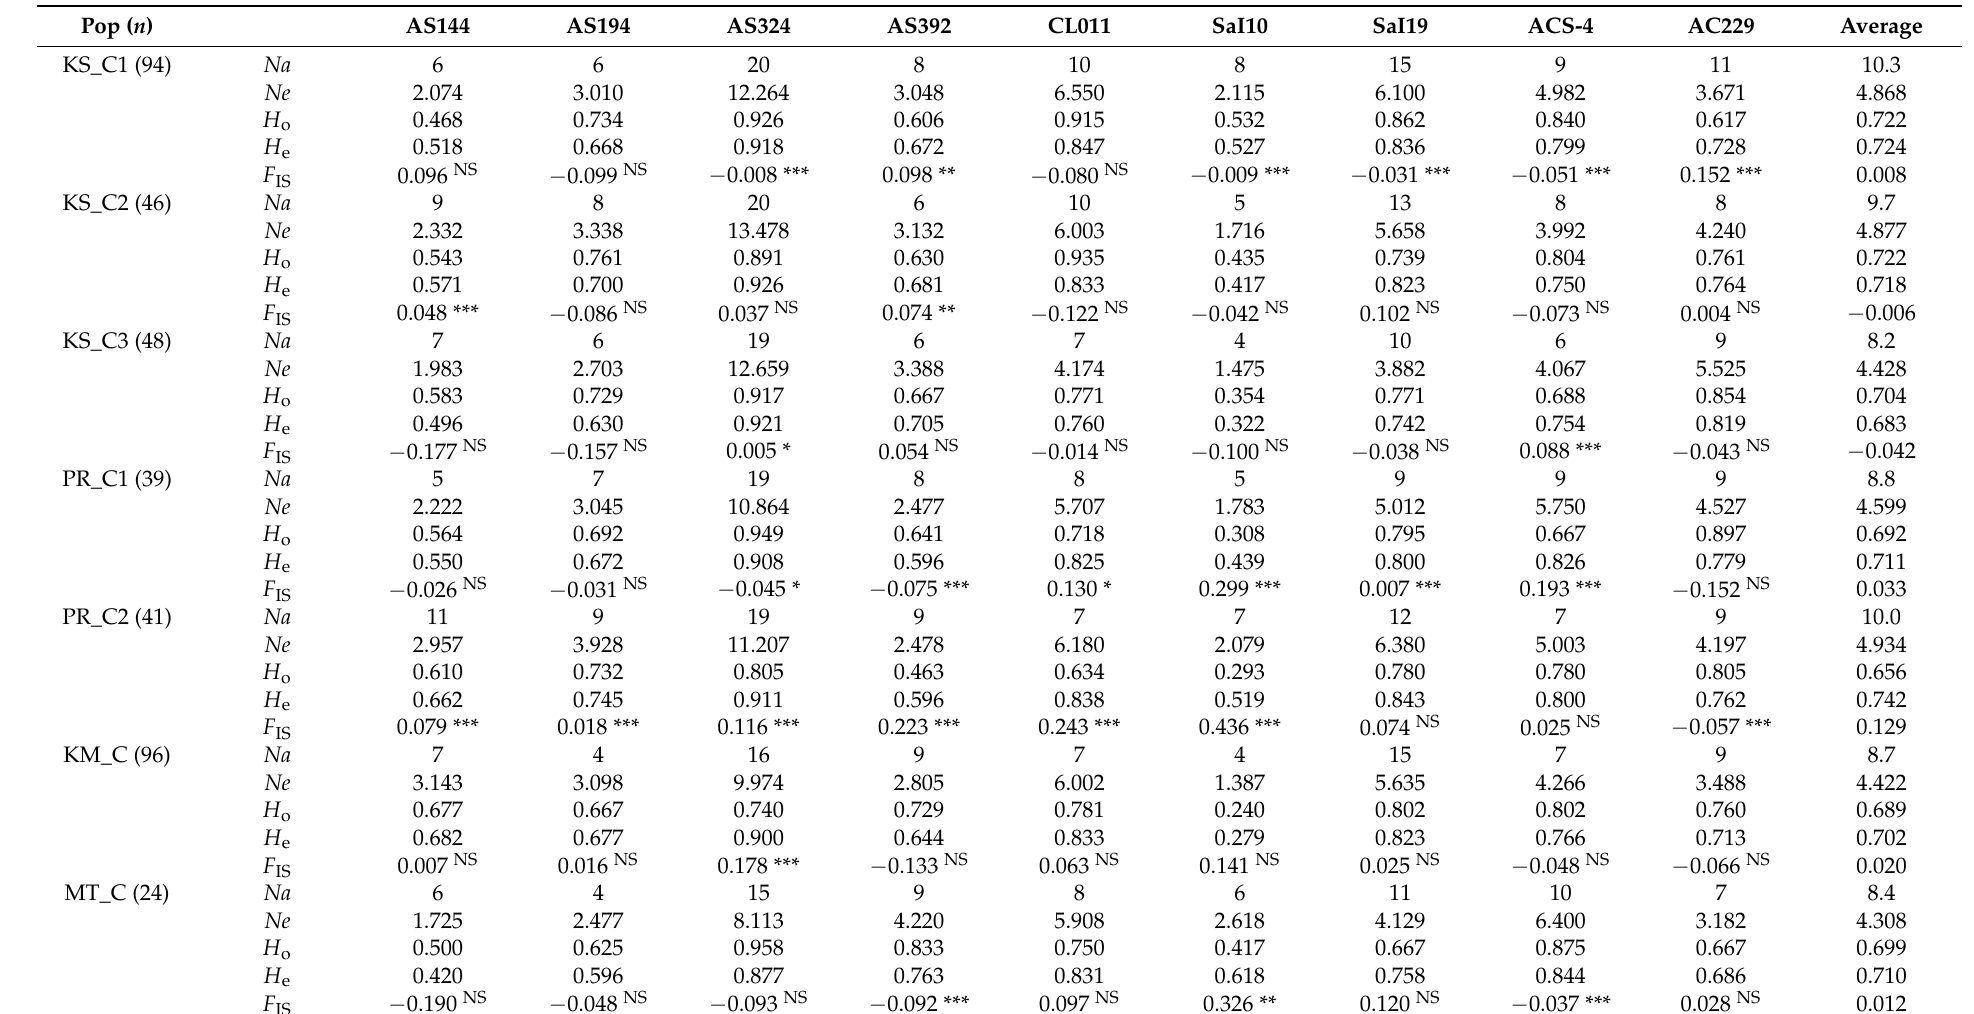
Table 4. Summary statistics for genetic variation at nine microsatellite loci in nine cultured black sea bream